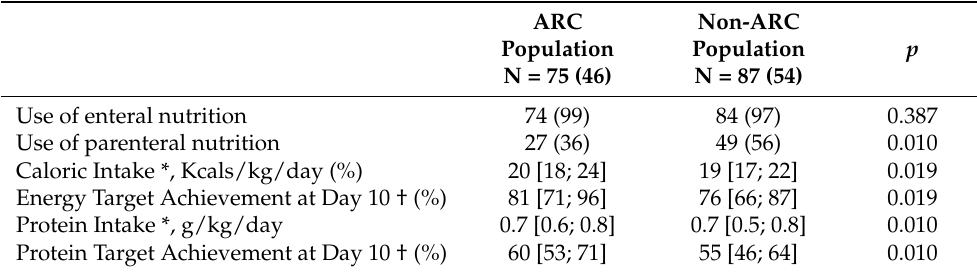
Table 3. Nutritional parameters compared in ARC vs. non-ARC patients.